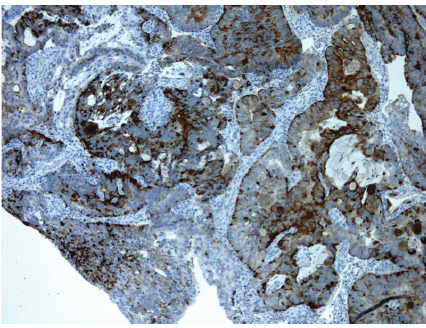
Figure 4: Medium-power image of immunostaining with anti- prostatic acid phosphatase, showing strong (brown) cytoplasmic